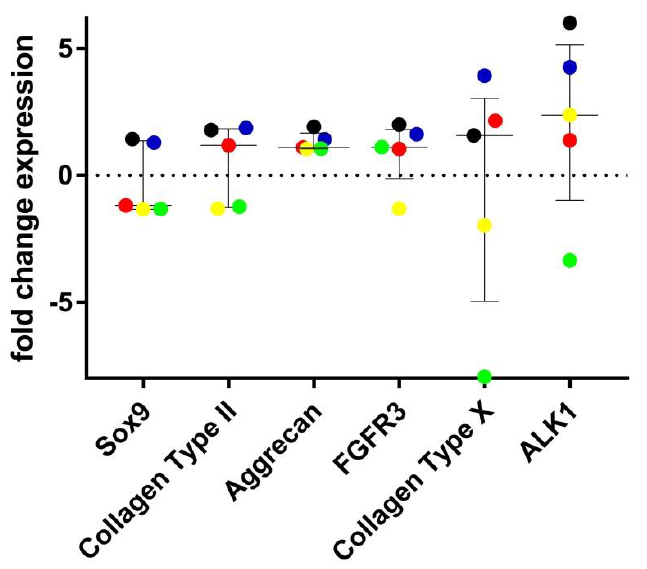
Figure 7. Analysis of the effects of heparanase treatment on gene expression of chondrocytes in monolayer culture ( n = 5). Results are presented as log-fold change in the expression of the chondrogenic genes SOX9, collagen type II, aggrecan, FGFR3 and hypertrophy genes collagen type X and ALK1 in chondrocytes that were treated with heparanase compared to the untreated controls. Matched samples are represented by the same colour dot; donor 16 (black), donor 17 (red), donor 18 (blue), donor 19 (green), and donor 20 (yellow). Error bars indicate medians and interquartile ranges.